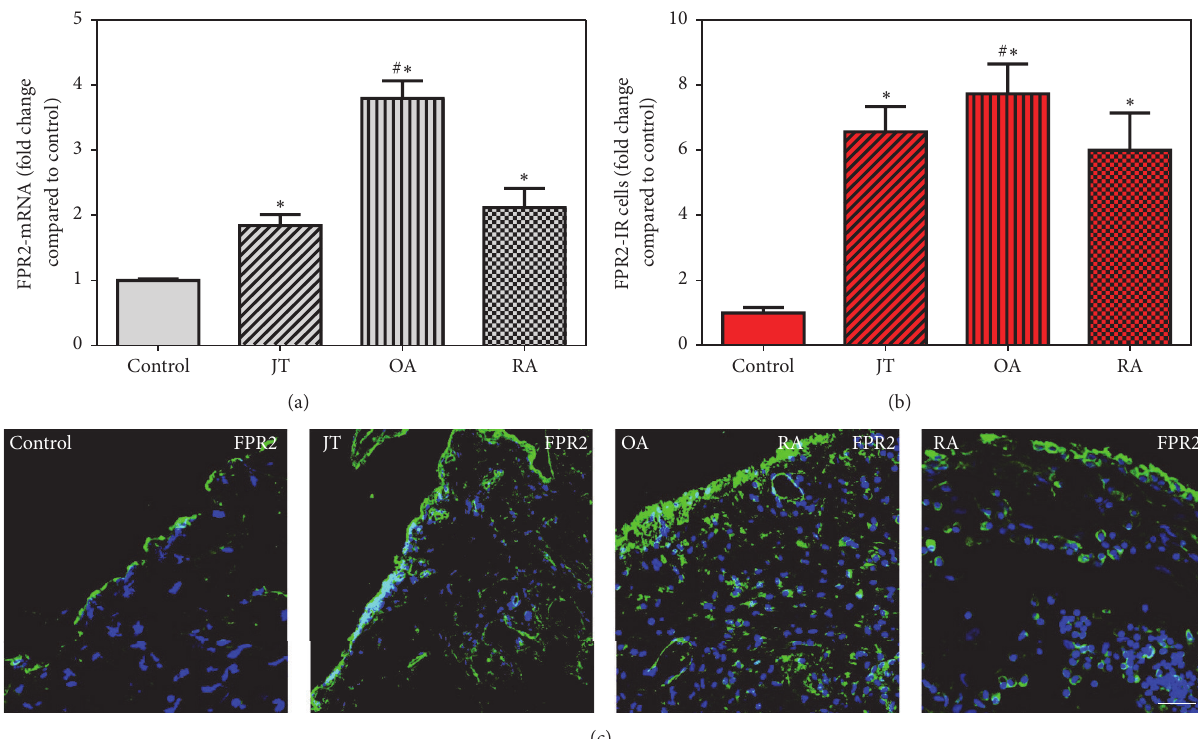
Figure 2: Detection of FPR2 mRNA (a) and number of FPR2-IR cells (b and c) in patients with joint trauma (JT), osteoarthritis (OA), and rheumatoid arthritis (RA). Quantification of FPR2 mRNA (a) and immunofluorescence positive cells (b) shows that FPR2 expression was more prominent in OA compared to RA, JT, OA. ∗ Relative to control, # relative to other groups ( 𝑃 < 0.05 , one-way ANOVA followed by Tukey’s test). Data are shown as means ± SEM. (c) 5-LOX-IR cells are more abundant in RA synovium than in JT, OA, and control synovium. SEM. Bar = 20 𝜇